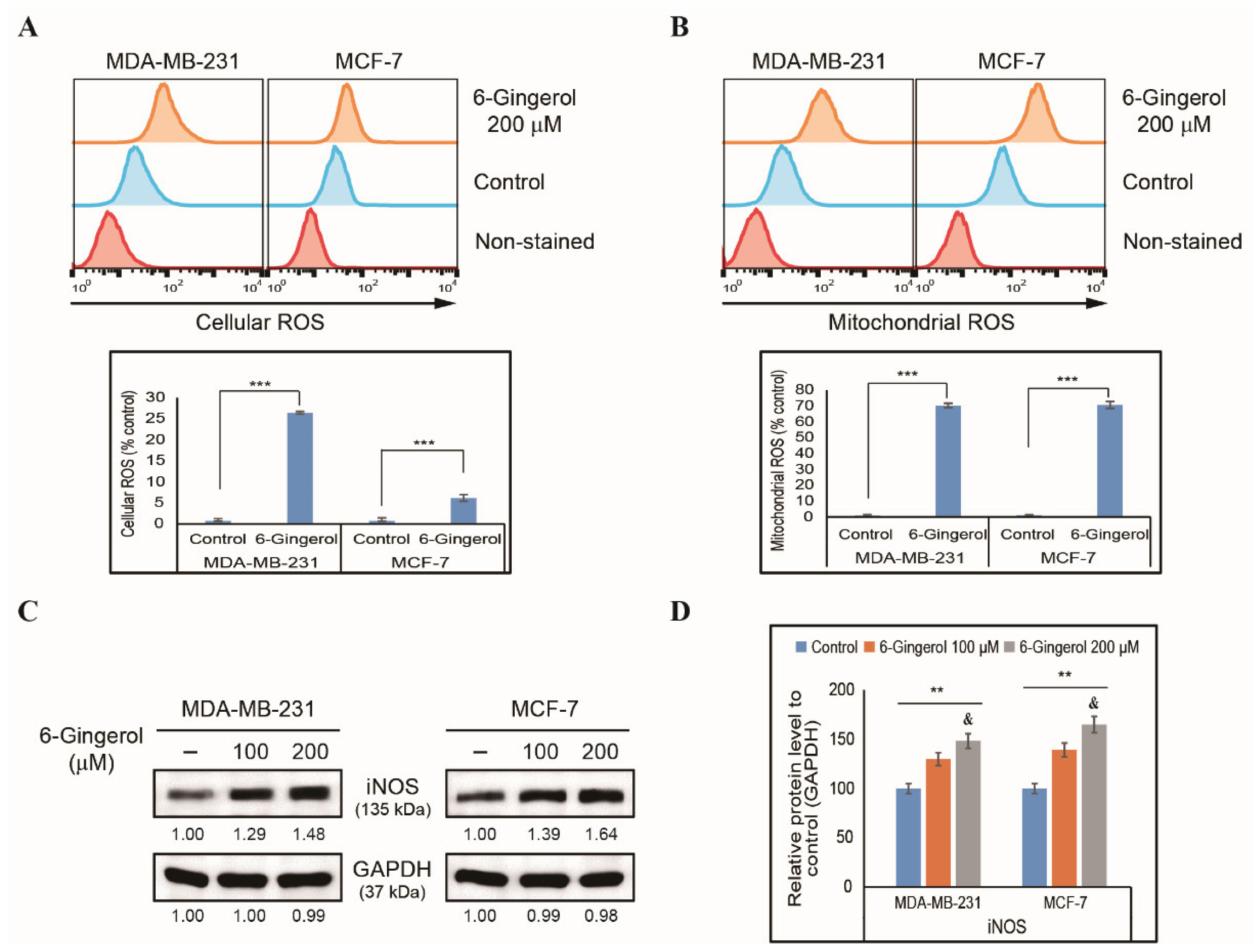
Figure 1. Induction of ROS in breast cancer cells by 6-gingerol. ( A ) Flow cytometry analysis of cellular ROS in MDA-MB-231 and MCF-7 cells after treatment with 6-gingerol for 48 h. Graphical representation shows the percentage of cells with ROS induction. Values are presented as mean ± SEM of three independent experiments performed in triplicate (n = 3). *** p < 0.001 (Student’s t -test). ( B ) Flow cytometry analysis of mitochondrial ROS by 6-gingerol in MDA-MB-231 and MCF-7 cells for 48 h. Graphical representation shows the percentage of cells with mitochondrial ROS. The values are presented as mean ± SEM of three independent experiments performed in triplicate (n = 3). *** p < 0.001 (Student’s t -test). ( C ) Western blotting of MDA-MB-231 and MCF-7 cells with 100 and 200 µ M 6-gingerol for 48 h showing the expression of iNOS. ( D ) The relative expressions of iNOS proteins were determined via densitometry and normalized to GAPDH. Controls are set to 100. Data were confirmed after repeating the experiment three times. ** p < 0.01 (ANOVA test) and p < 0.01 vs.